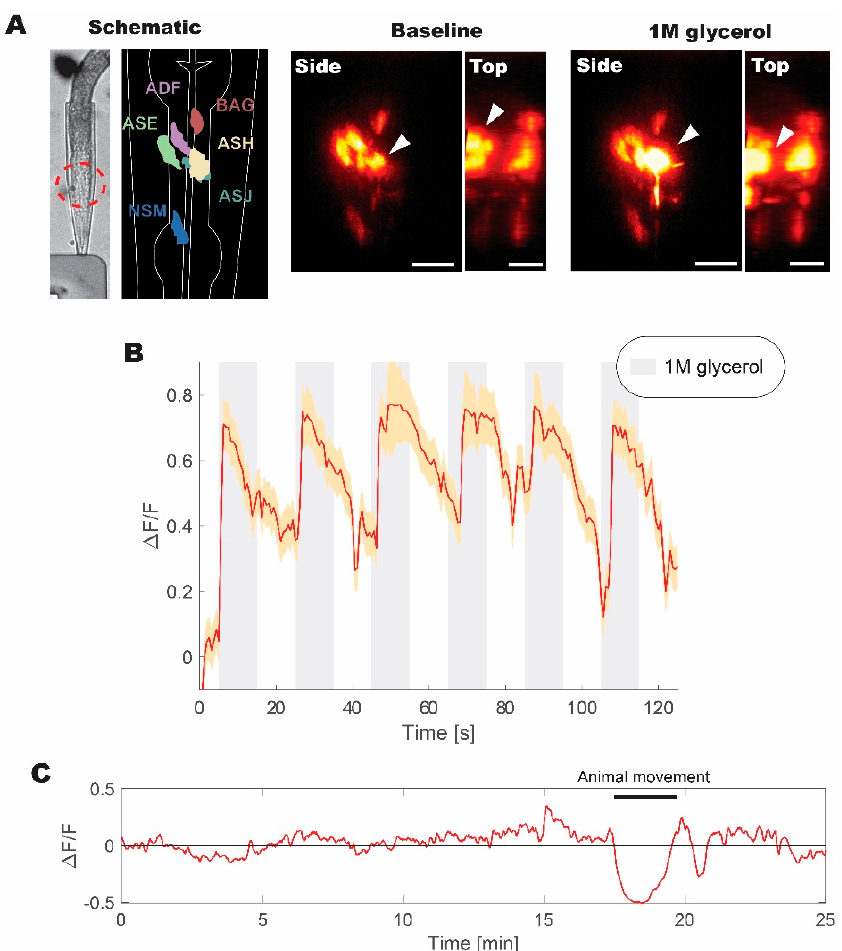
Figure 5. Live volumetric imaging of C. elegans responding to 1 M glycerol solution measured at 100 kHz. ( A ) Bright-field image of animal immobilized in a microfluidic device, and corresponding schematic diagram of imaged neurons, as well as examples of neuronal calcium activity at the baseline and when stimulated with 1M glycerol solution (shown from the side and top directions). Red dashed circle indicates the imaged region of interest. White arrows indicate the position of ASH sensory neuron cell body. ( B ) Normalized fluorescence change recorded for six pulses of 1M glycerol with a period of 40 s between pulses. ( C ) Continuous volumetric recording of baseline neural activity in ASH neuron without stimulus application. A sudden decrease in the signal at 18 min. is due to animal movement in the microfluidics device. Volumetric data were acquired at ~2 Hz with 30 ms exposure per slice. Normalized fluorescence change was calculated from the mean of volumetric fluorescence. Error bars represent standard error of the mean derived from measurements of individual pixels in the recording. Scale bars denote 10 µm.